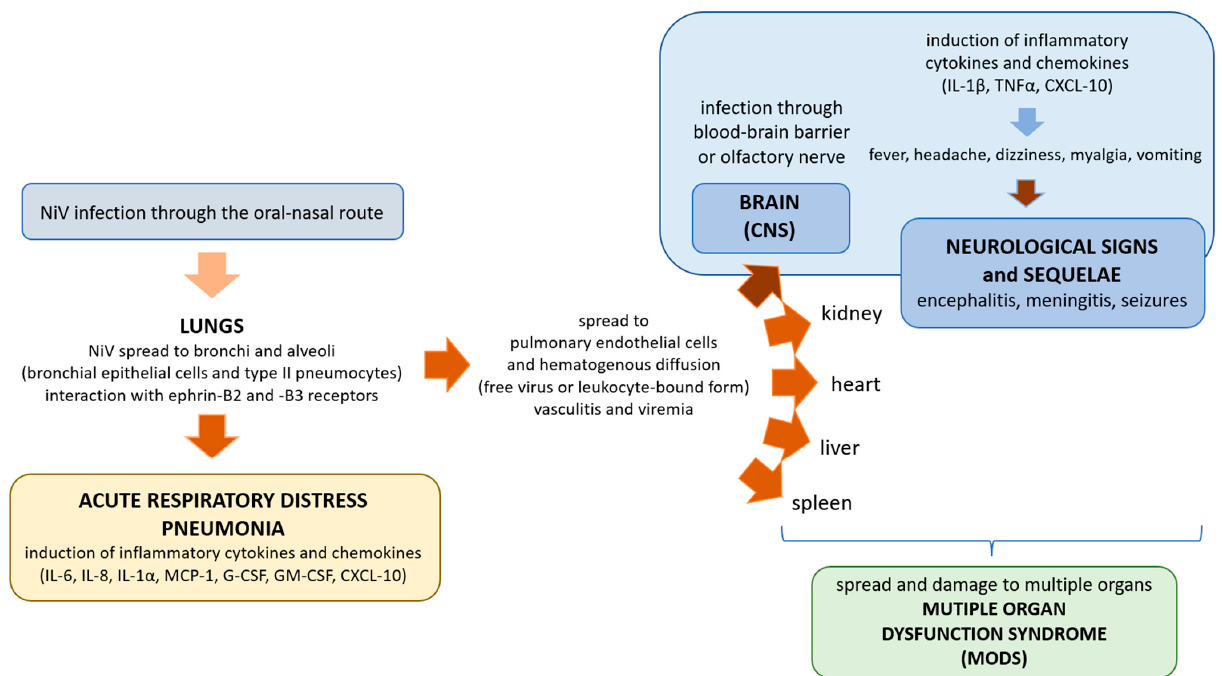
Figure 4. Schematic representation of the NiV pathogenesis. The virus enters the host through the oral-nasal route and spreads into the upper and lower respiratory system, including bronchi, bronchioles and alveoli where bronchial epithelial cells and type II pneumocytes are the major susceptible cells to infection. The first phase of infection is characterized by pneumonia and acute respiratory distress triggered by the release of inflammatory cytokines and chemokines in the lung. Pulmonary endothelial cells are secondary target cells which allow the virus to enter the peripheral circulation and spread into the body as free virus or carried by leukocytes (especially lymphocytes and monocytes), also causing a severe vasculitis and inducing viremia. The virus can reach different organs and induce multiple organ dysfunction syndrome (MODS). The spread to the brain and central nervous system (CNS) induces the release of inflammatory mediators responsible for systemic clinical signs and eventually leading to severe forms of neurological diseases, which mostly lead the host to death or severe impairment. NiV infection can lead to long-term neurological sequelae, late-onset encephalitis or relapse encephalitis after recovering from a symptomatic initial infection. IL: interleukin; MCP: monocyte chemoattractant protein; G-CSF: granulocyte colony stimulating factor; GM-CSF: granulocyte-macrophage colony stimulating factor; CXCL: C-X-C motif chemokine ligand; TNF- α : tumor necrosis factor